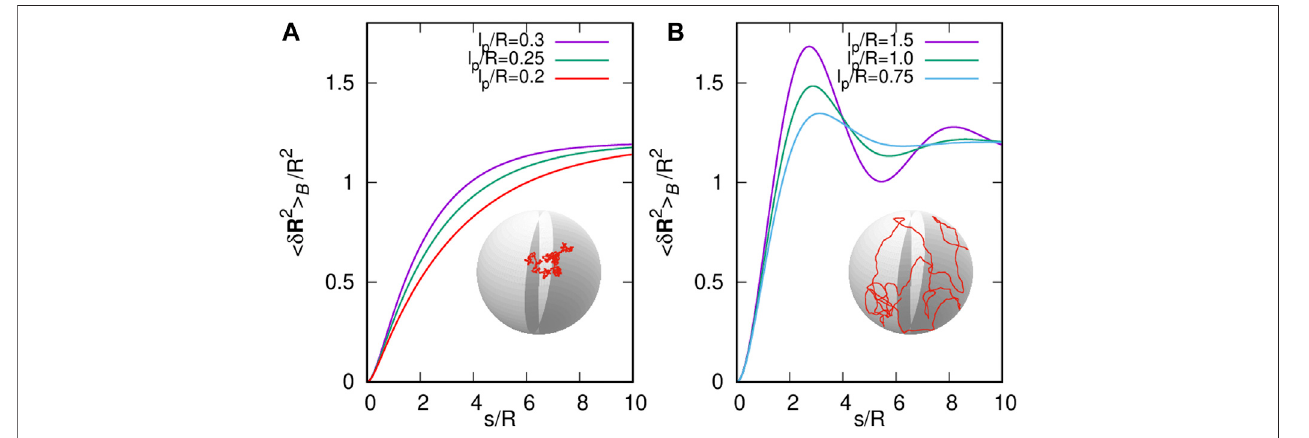
FIGURE 2 | Monotonous and oscillating behaviors of the mean-square end-to-end distance ( Eq. 37 ) of polymers with ℓ p below (A) and above (B) the critical (cid:12)(cid:12) √ persistence length ℓ p p (cid:1) 3 R / ( 2 α 1 ) in spherical con fi nement. Inside the plotting area, we sketch the conformational states of each class of polymers.